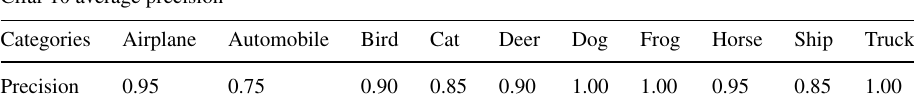
Fig. 4 a Average precision. b Average recall Table 1 Average precision for cifar 10